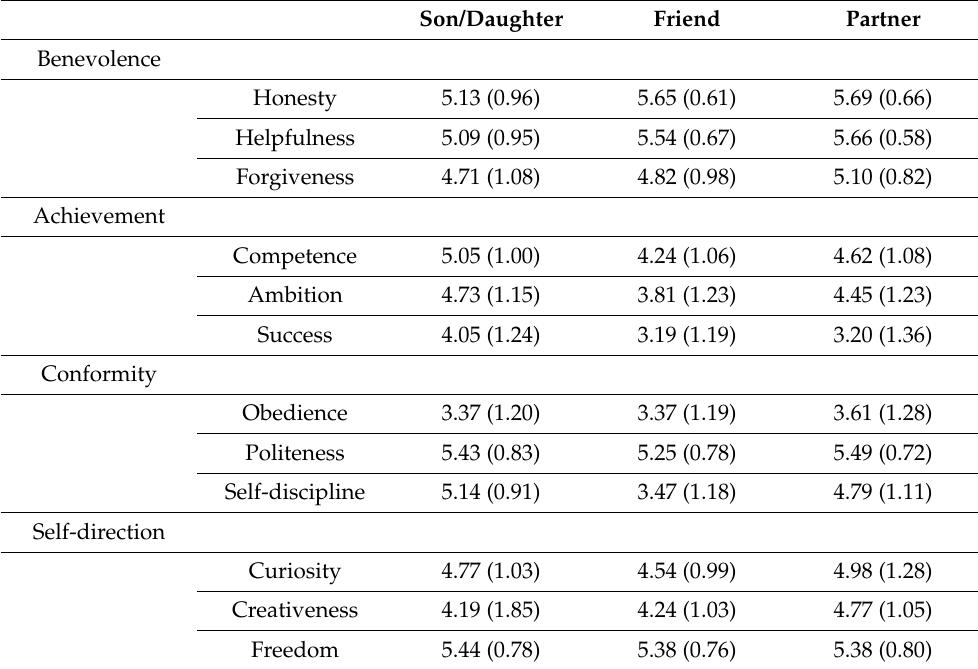
Table 1. Means and standard deviations of values across roles.